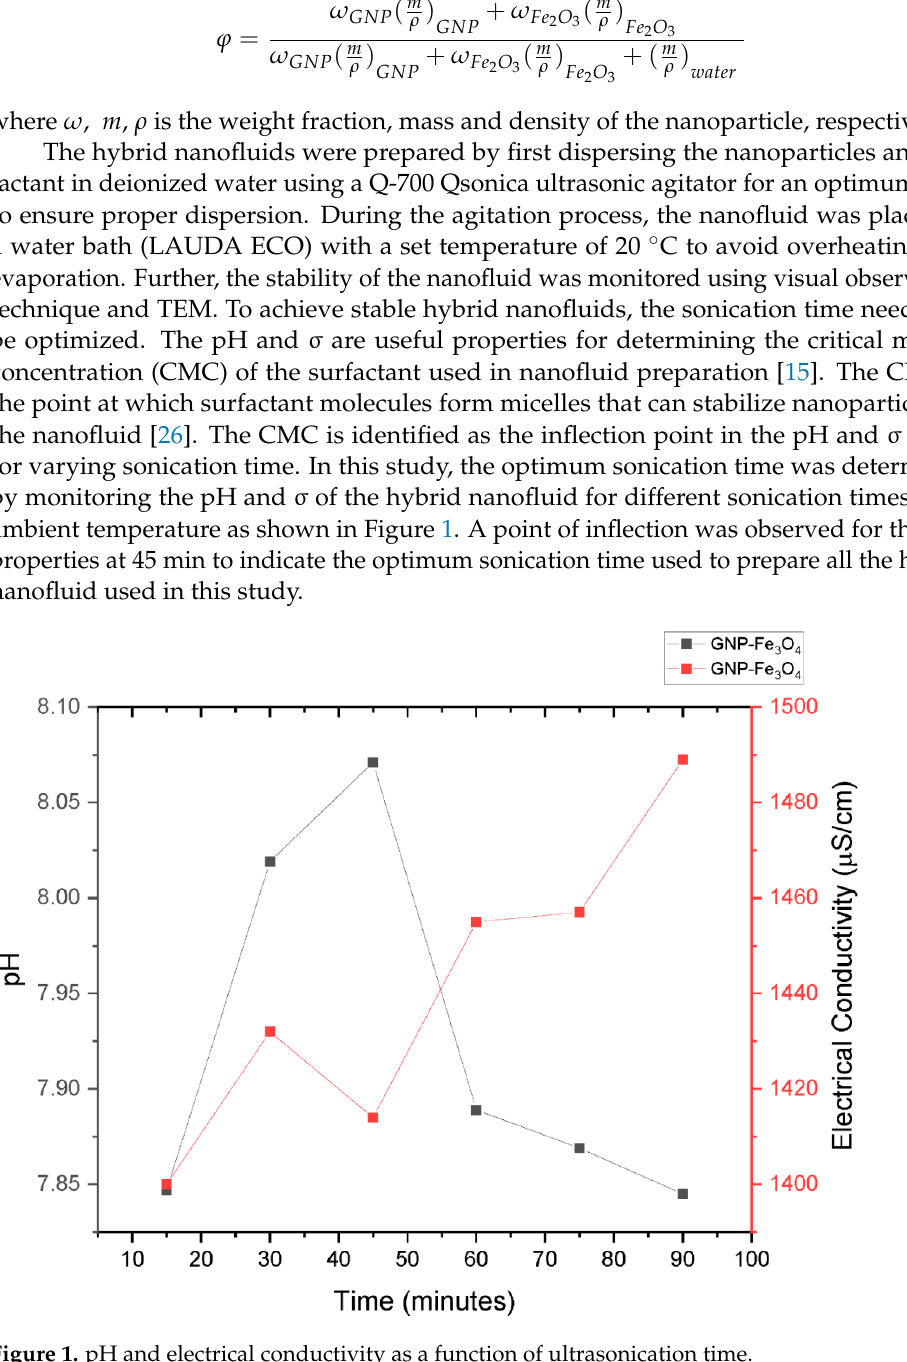
Figure 1. pH and electrical conductivity as a function of ultrasonication